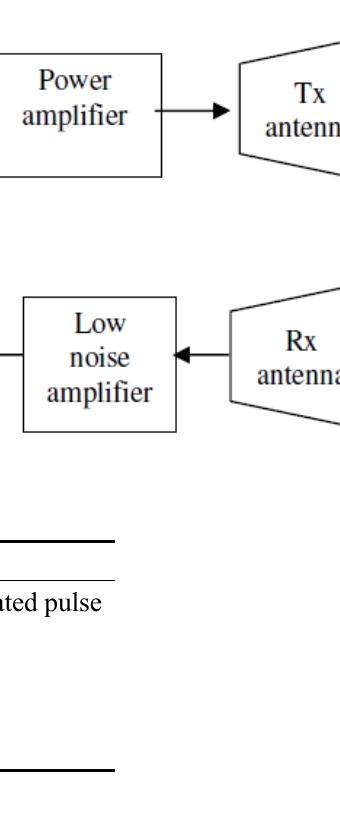
Figure 1. Notional block diagram of the multimodal radar.